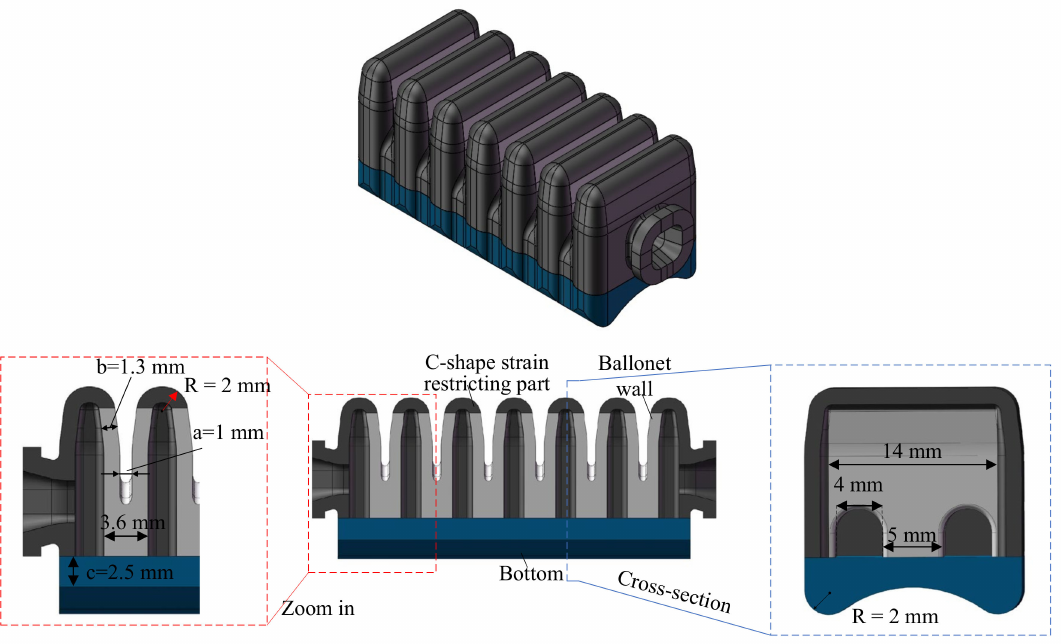
Figure 1. Structure of the pneumatic